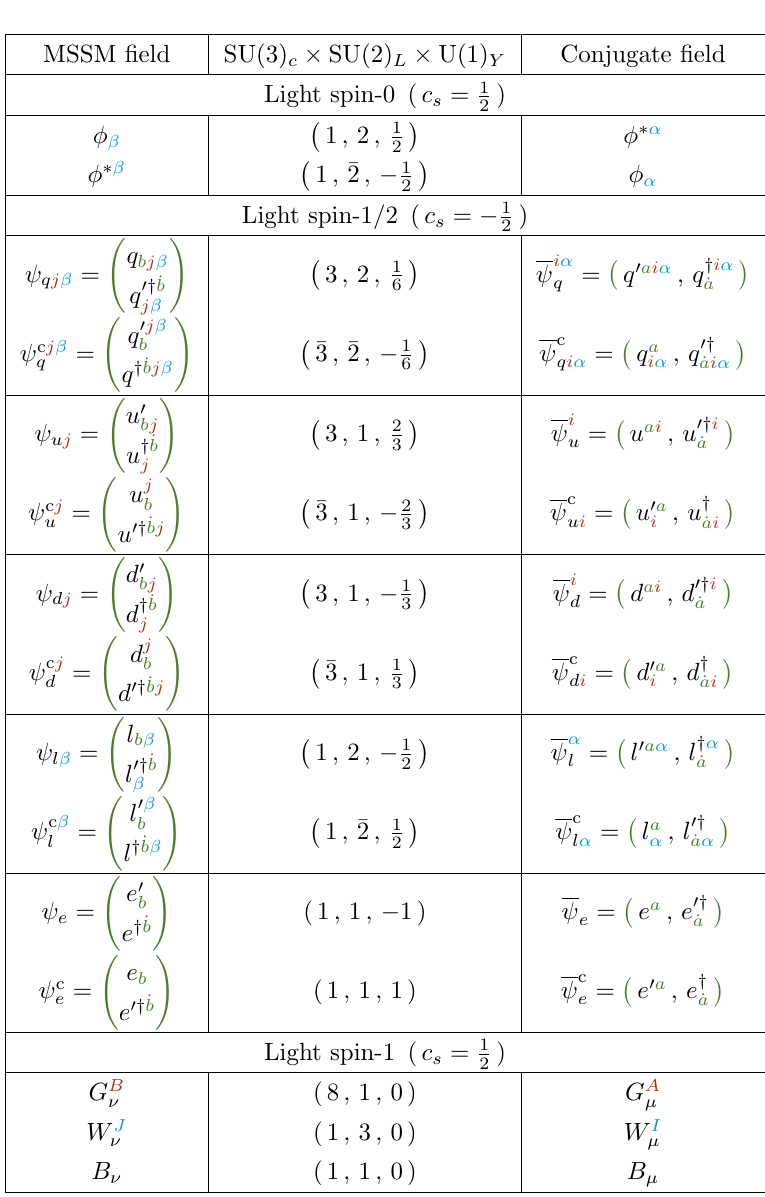
Table 3 . Light (cid:12)elds ’ L in the MSSM, their gauge quantum numbers, and conjugate (cid:12)elds (which appear on the left side of Q UV , see footnote 3). For clarity, SU(3) c , SU(2) L and spinor indices are in brown, blue and green, respectively. Primed Weyl fermion (cid:12)elds are unphysical auxiliary (cid:12)elds, to be set to zero at the end of the